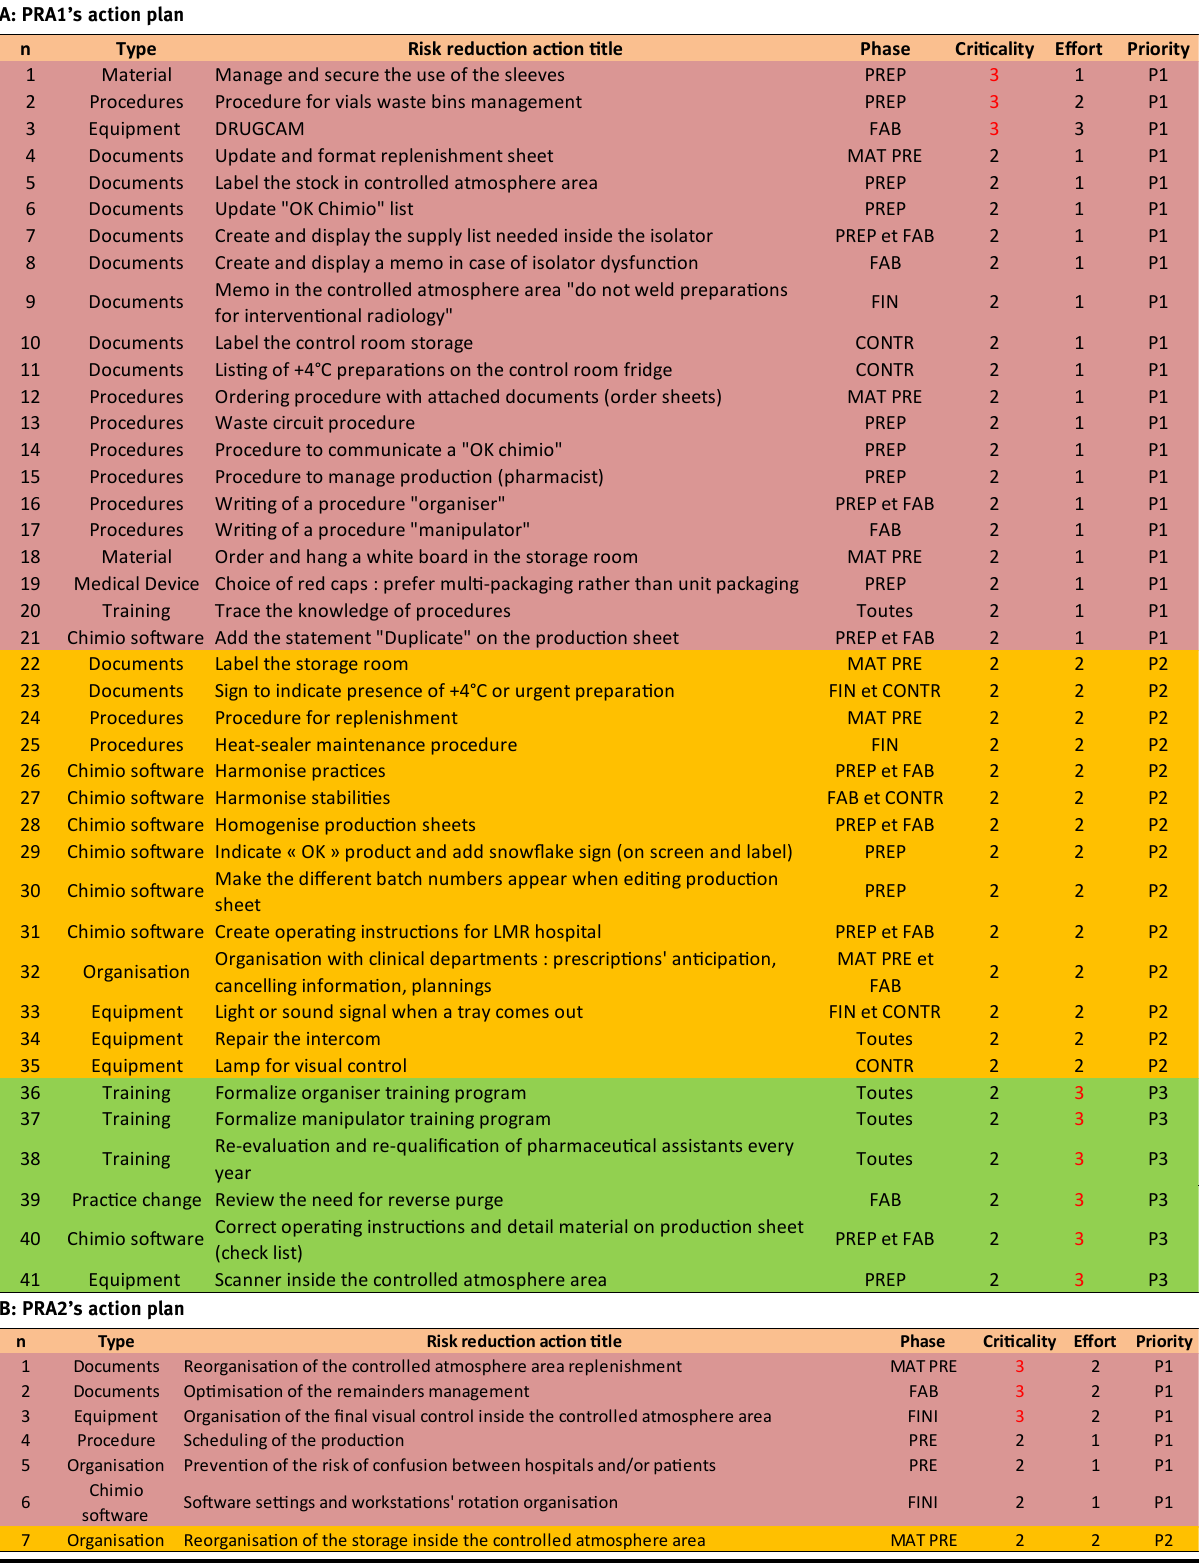
Table  : Action plans for PRA  and PRA  .